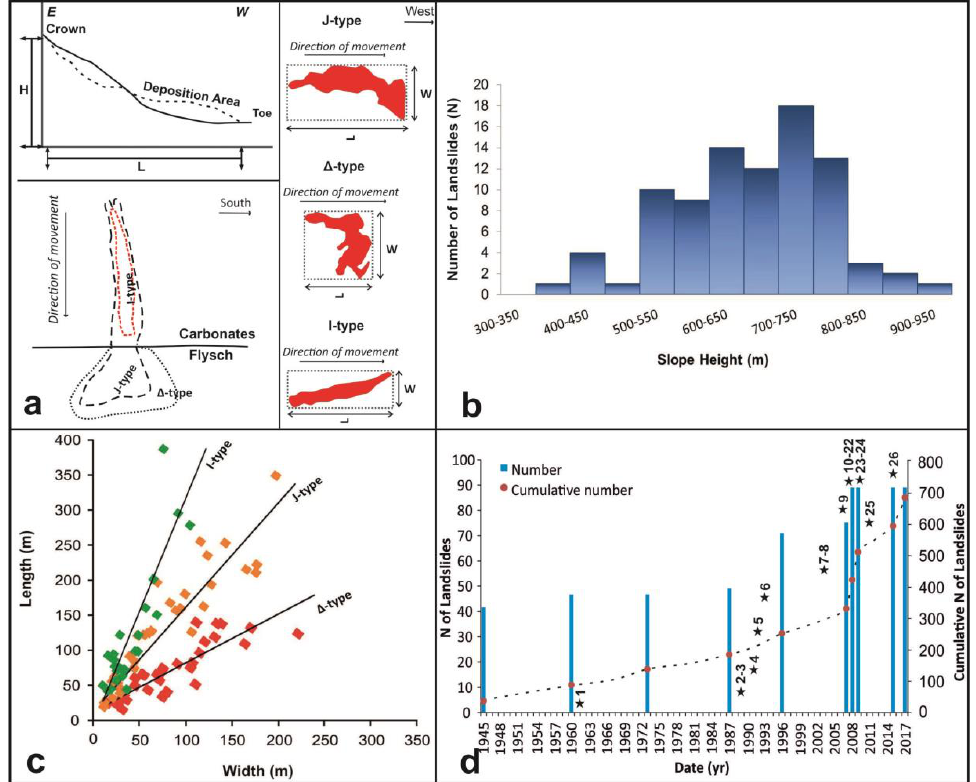
Figure 4. ( a ) Definitions of geometric parameters of Skolis Mtn landslides and the minimum bounding rectangle method; ( b ) Histogram showing the landslide spatial distribution in Skolis Mtn in terms of the crest height; ( c ) Plot showing the landslides aspect ratio during 2017. The solid black lines represent the best fit line between the length and width of the three landslide types of the table. ( d ) Chart showing the number (bars) and the cumulative number of landslides (dots) in the 1945–2017 time intervals. The stars show the earthquake events that appeared in Figure 8c. For the date of each earthquake, see Figure 8c.